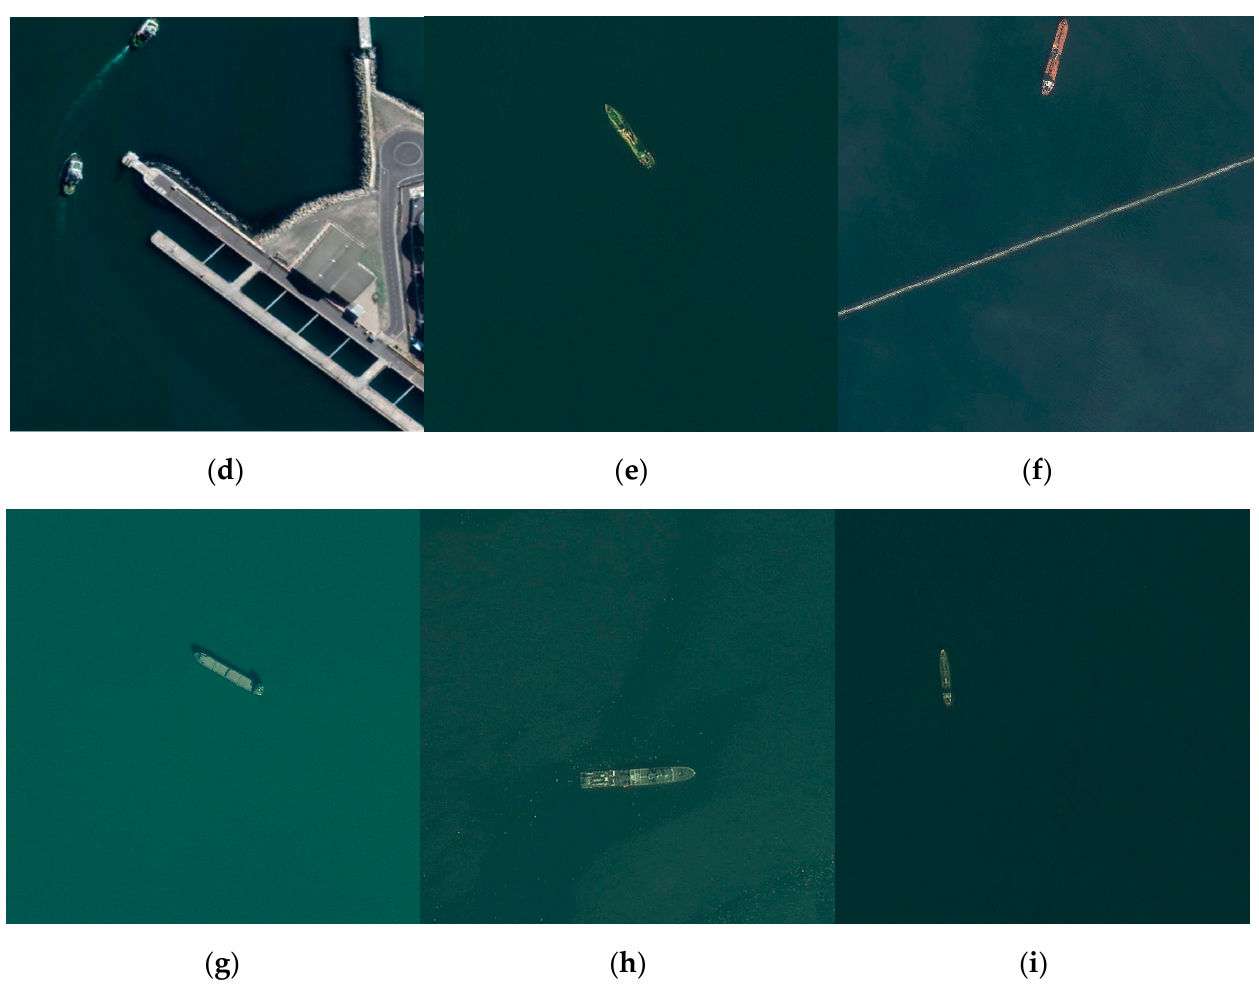
Figure 1. Class 9 ship targets in FAIR1M: ( a ) passenger ship (Ps); ( b ) motorboat (Mb); ( c ) fishing boat (Fb); ( d ) tugboat (Tb); ( e ) engineering ship (Es); ( f ) liquid cargo ship (Lc); ( g ) dry cargo ship (Dc); ( h ) war ship (Ws); ( i ) other ship (Os).